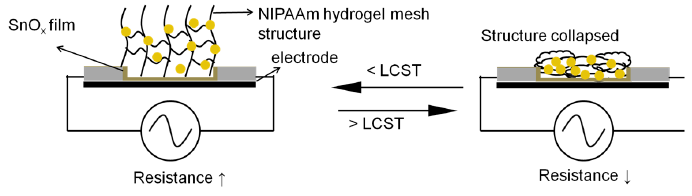
Figure 5. Morphological changes in NIPAAm hydrogel structure.